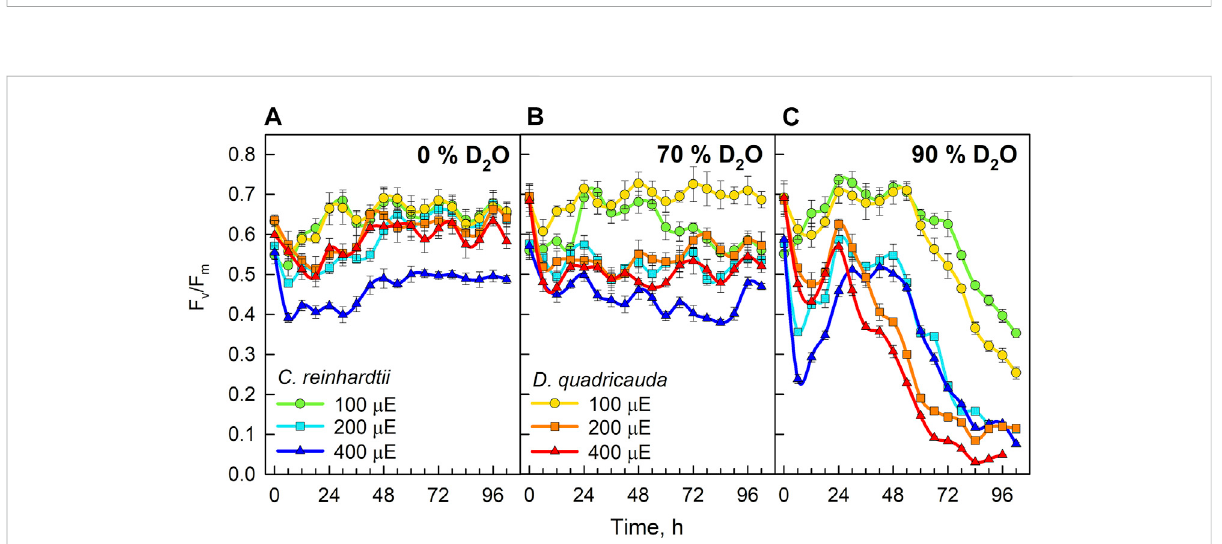
FIGURE 12 F v /F m ratioofculturesgrownin0%D 2 O (A) ,70%D 2 O (B) or90%D 2 O (C) atthreelightintensities100,200,and400 μ molphotons · m − 2 · s − 1 .Light intensities are given in μ E (instead of μ mol photons · m − 2 · s − 1 ), in order to fi t the legends.